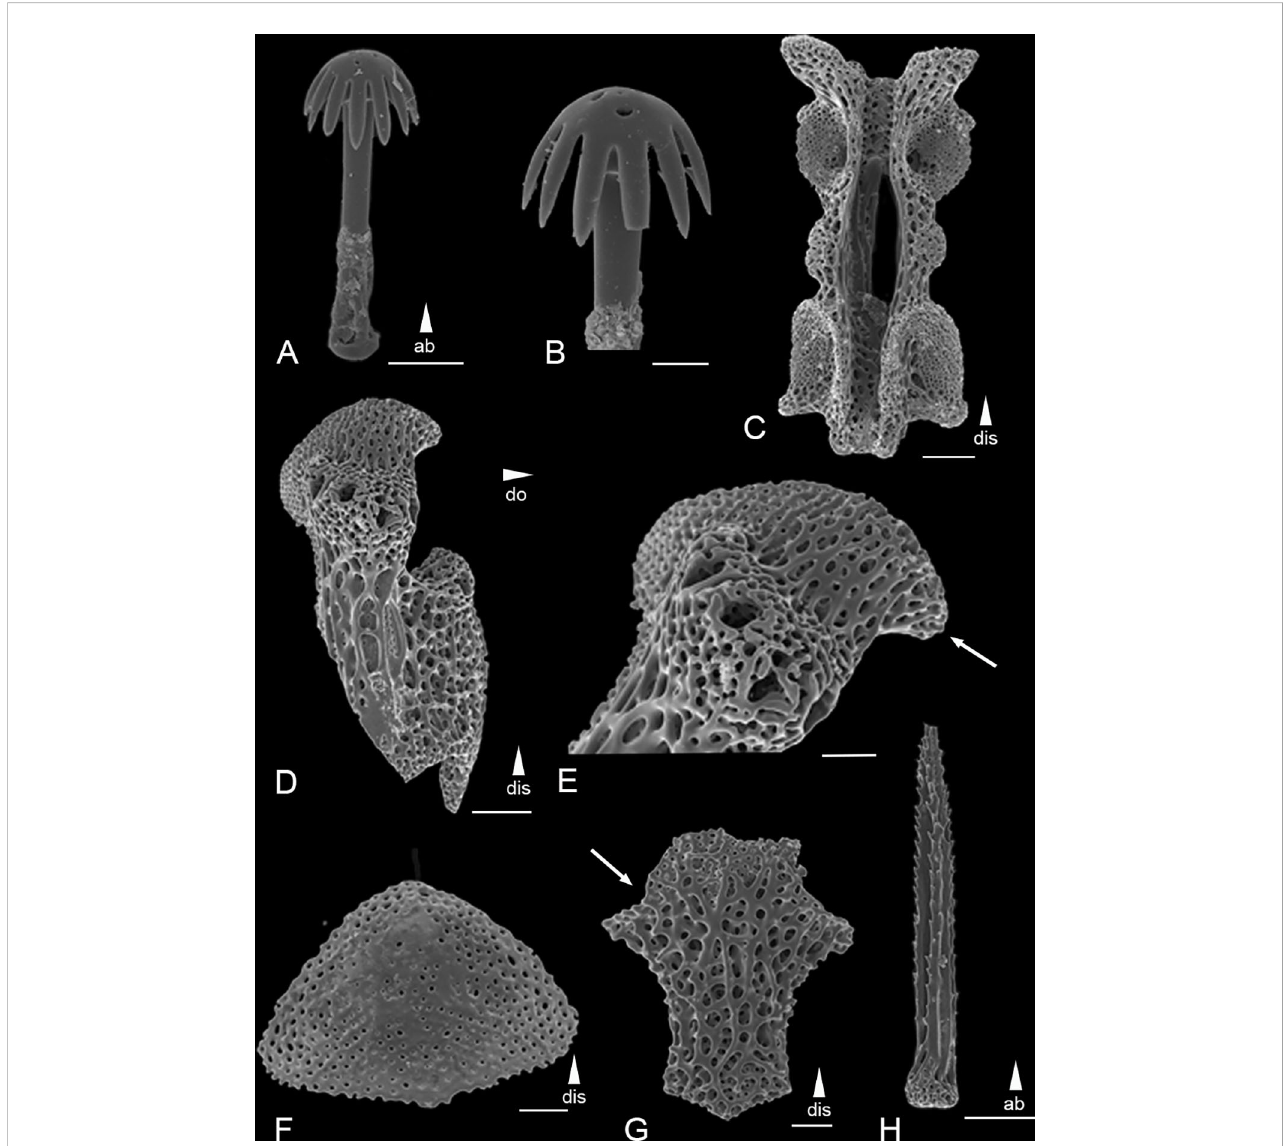
FIGURE 4 Scanning electron microscope images of the ossicles from Ophiotholia mitrephora . (A) : Parasol-spine; (B) : Head of parasol-spine; (C) : Arm vertebrae (dorsal); (D) : Lateral arm plate; (E) : Close up lateral arm plate; (F) : Dorsal arm plate; (G) : Ventral arm plate; (H) : Arm spine. Scales: 20 µm (B) ; 50 µm (A, E – G) ; 100 µm (C, D, H) ;. ab, abradial; dis,